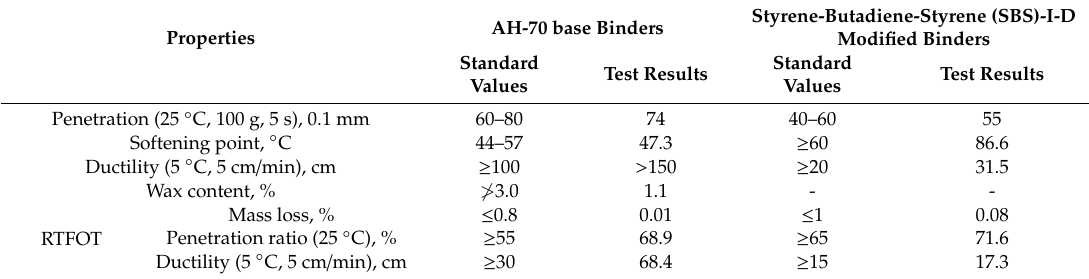
Table 1. Properties of asphalt binders.